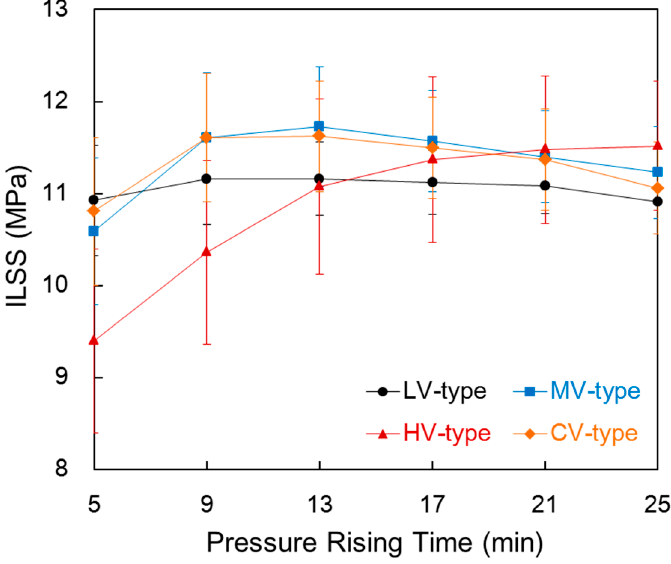
Figure 8. Interlaminar shear strength (ILSS) of the composite compared with the pressure rising time in each film stacking type.